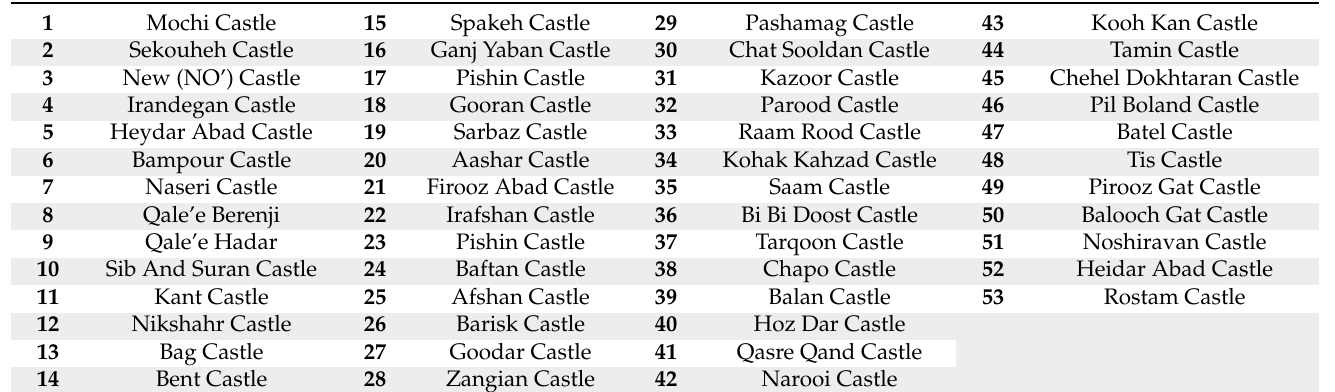
Table 1. List of historical castles in